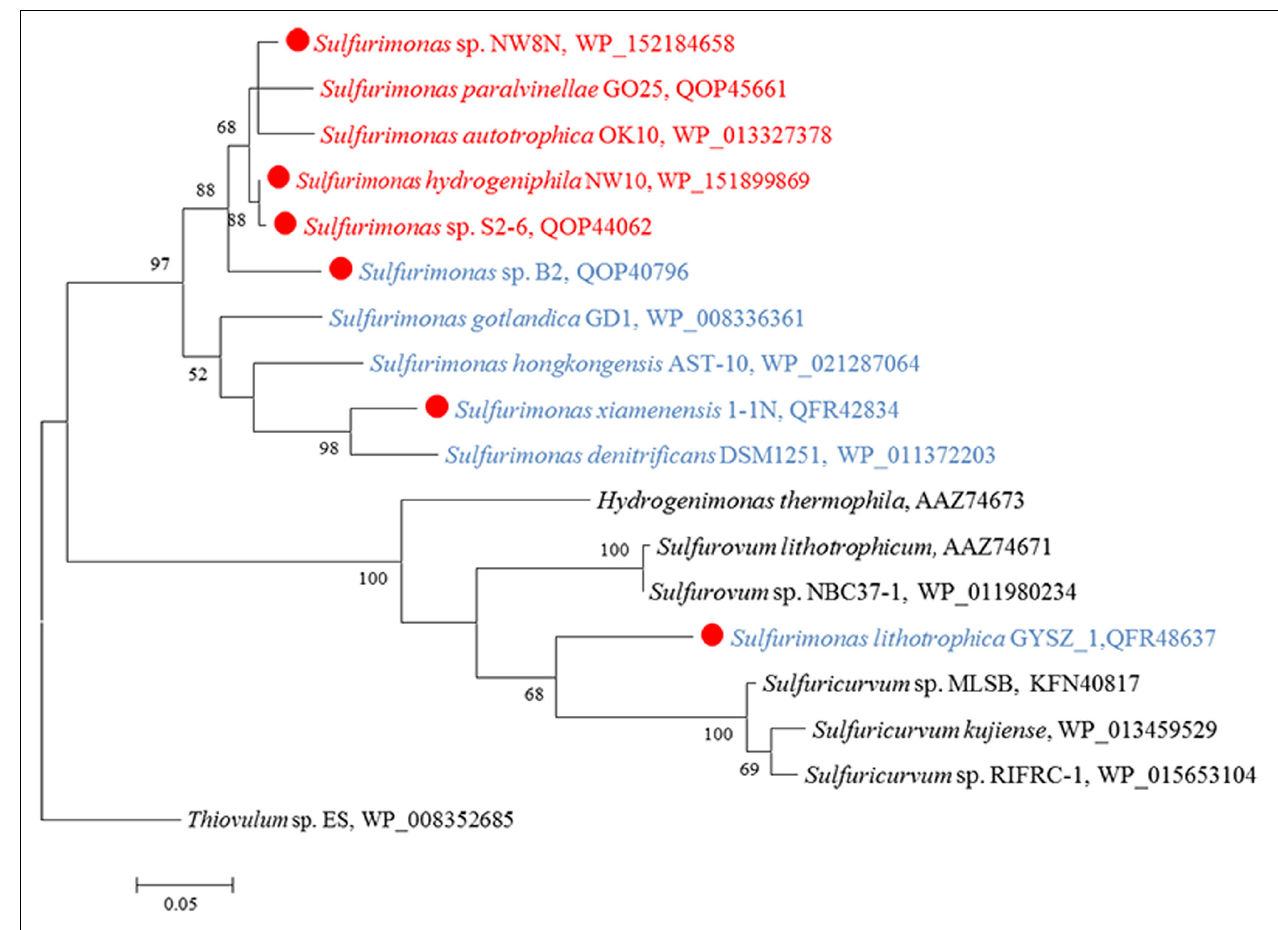
FIGURE 8 | Maximum likelihood phylogenetic tree of the AclB protein sequences derived from Sulfurimonas strains and other representative species within the class Campylobacteria . Bootstrap values indicated at each node are based on a total of 1,000 bootstrap replicates. Branch node values below 50% are not shown. The solid red circles represent our own isolated strains. Isolation sources of Sulfurimonas species are indicated in different font colors: red, hydrothermal environments; blue, marine non-vent